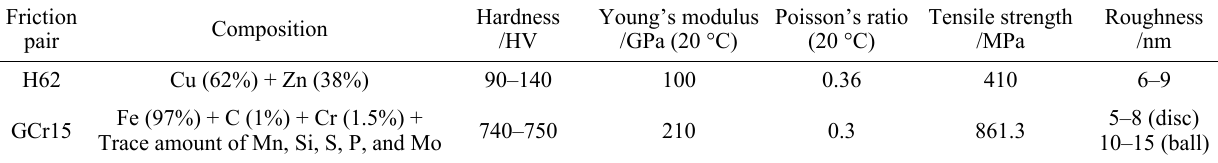
Table 1 The composition and mechanical parameters of the friction pairs. Friction Composition pair